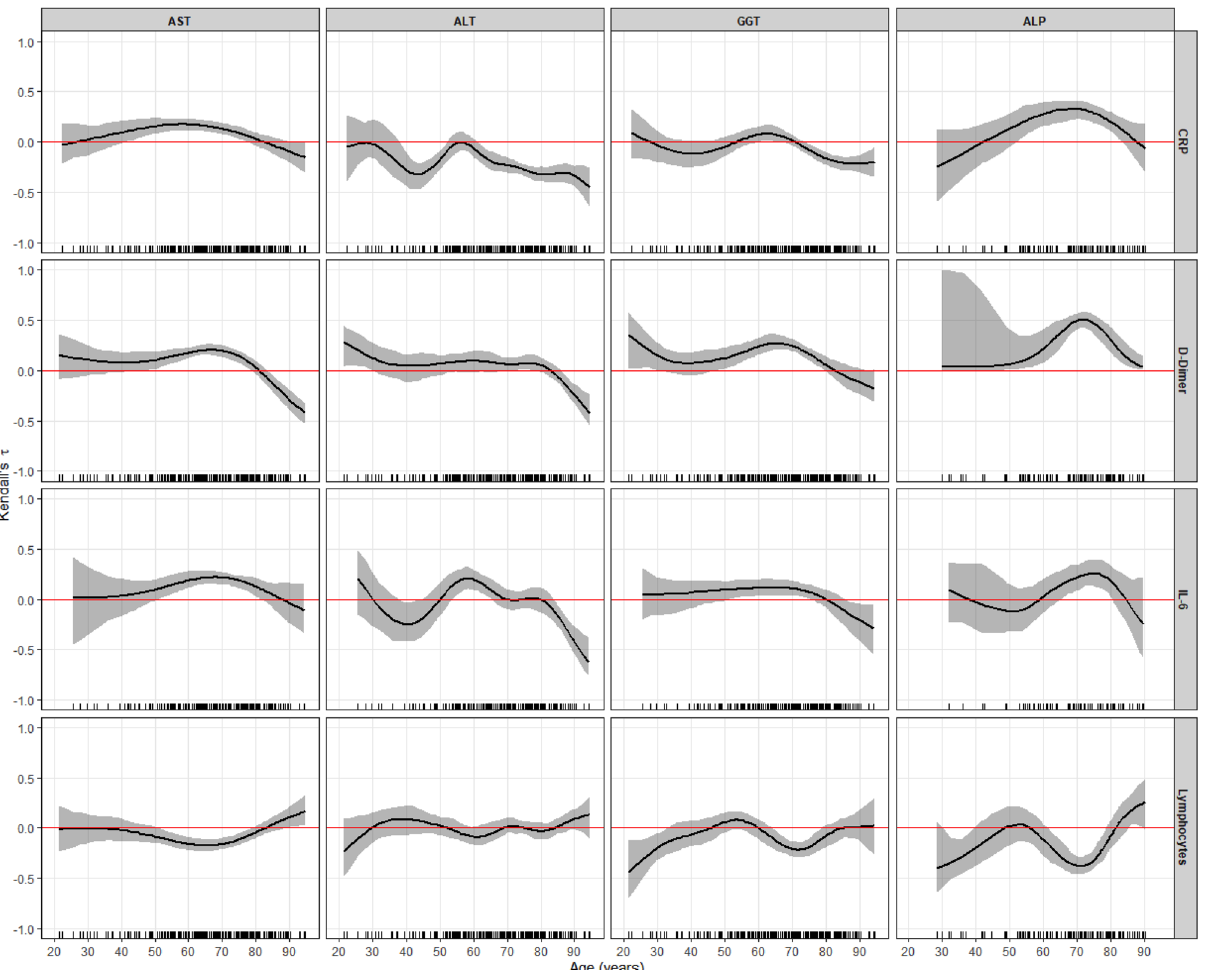
Figure 4. Variation of the correlation between the weighted and Box–Cox-transformed transaminases and the weighted and/or Box–Cox-transformed (if required) inflammation markers across the age of the patients, expressed by means of Kendall’s τ coefficient (with 95% CI). The horizontal red line indicates zero correlation, and when it lies inside the 95% CI, no correlation was